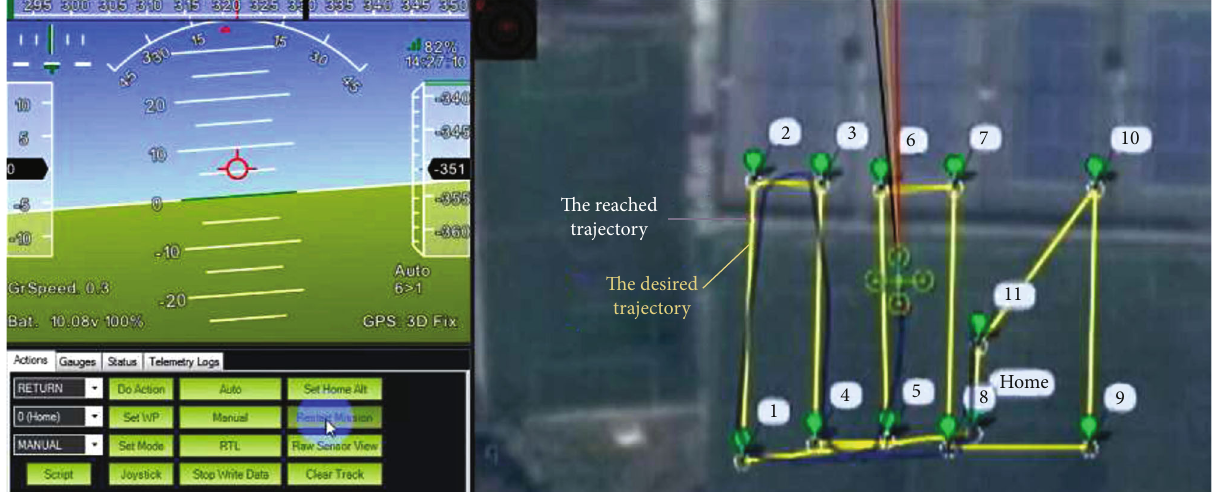
Figure 14: The Q-UAV reached and followed a desired zigzag-lined